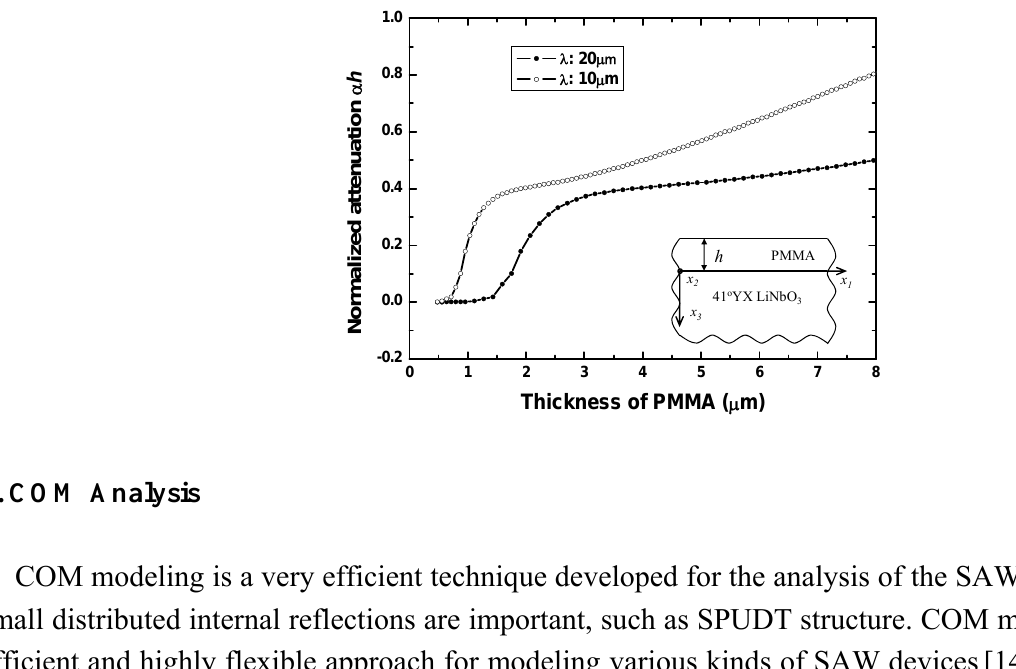
Figure 4. The attenuation coefficient versus PMMA guiding layer thickness as a function of different operation